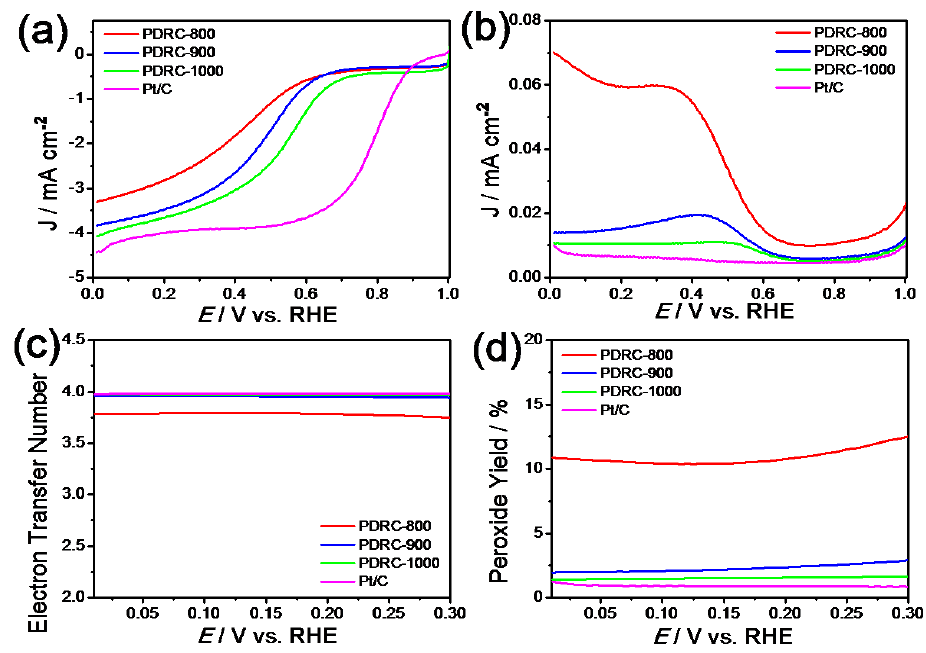
Figure 4. ( a,b ) RRDE voltammograms of PDRC-800, PDRC-900, PDRC-1000 and Pt / C in O 2 -saturated 0.5 M H 2 SO 4 ; ( c ) the n value and ( d ) H 2 O 2 yield of PDRC-800, PDRC-900, PDRC-1000 and Pt/C.